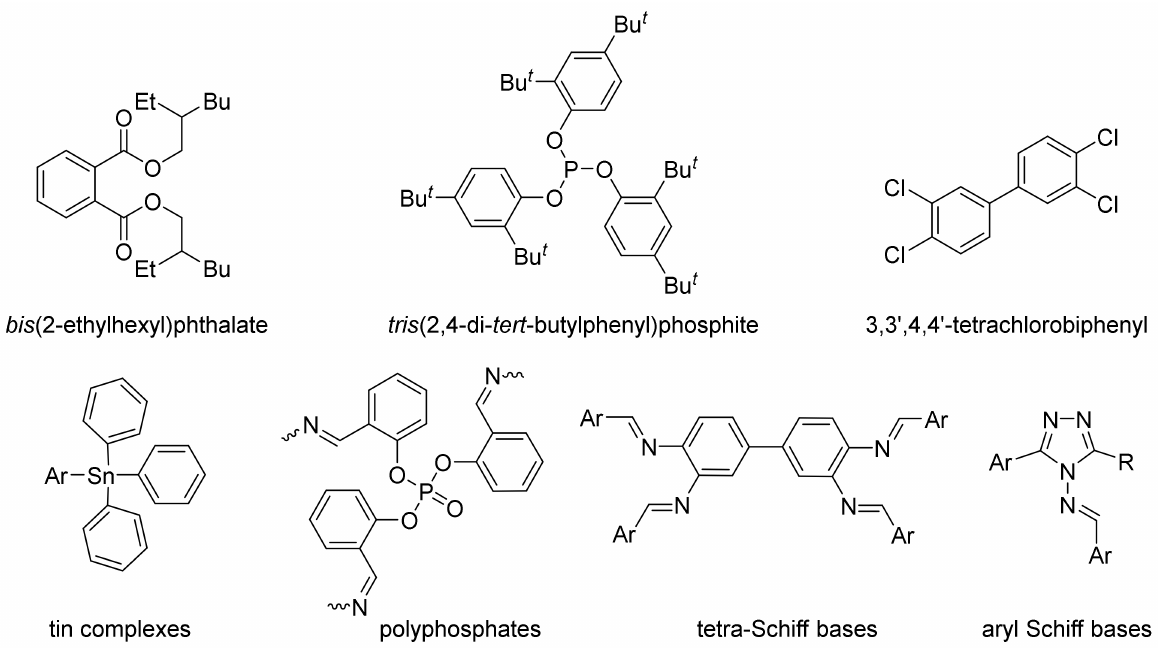
Figure 1. A selection of examples of PVC